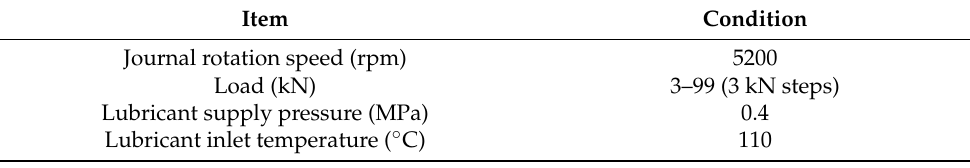
Table 6. Seizure test conditions.